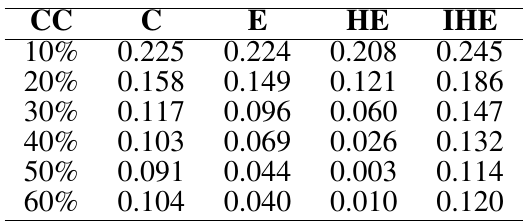
Table 3. The difference between the mean daily shadow fraction estimated from the voxel model and that estimated from the virtual forest. The average mean shadow fraction, calculated using the voxel model, is